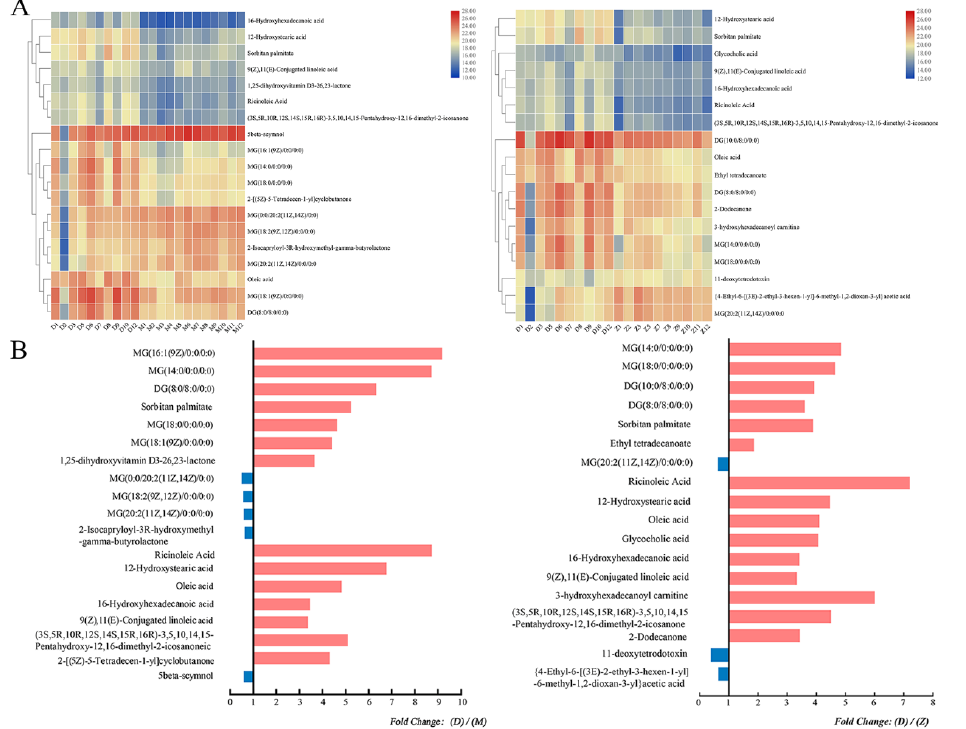
Figure 3. Hierarchical clustering analysis ( A ) and fold change ( B ) of the identified differential metabolites. Left: Significant different metabolites between group D (Mediterranean buffalo) and M (Murrah buffalo); right: Significant different metabolites between group D (Mediterranean buffalo) and Z (crossbred buffalo).